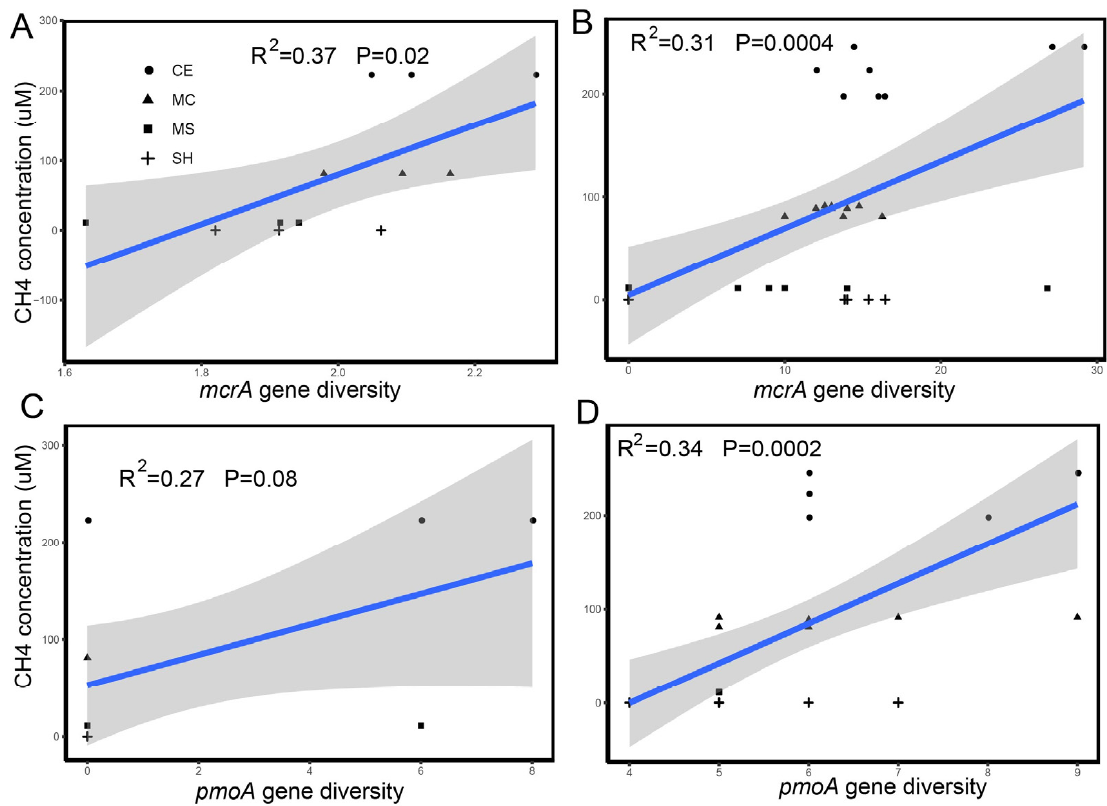
Figure 6. Relationship between the dissolved CH 4 concentration and alpha diversity of the functional gene mcrA and pmoA . ( A , B ) show the relationship between the dissolved CH 4 concentration and alpha diversity of functional gene mcrA in sediment and water. ( C , D ) show the relationship between the dissolved CH 4 concentration and alpha diversity of functional gene pmoA in sediment and water. Significant correlations are shown with a regression line.